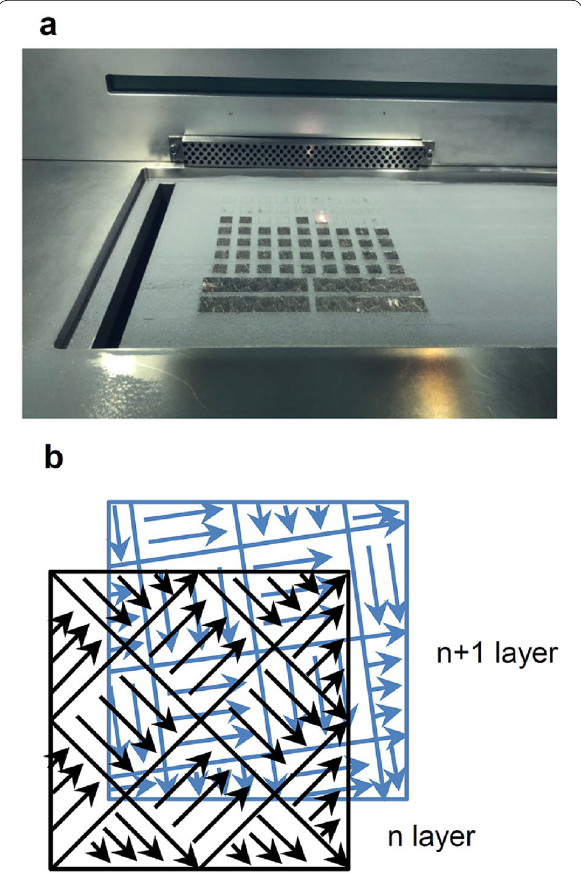
Figure 2 a Laser manufacturing process; b schematic presentation of laser scanning strategy (checker board with a rotation angle of 37° in successive